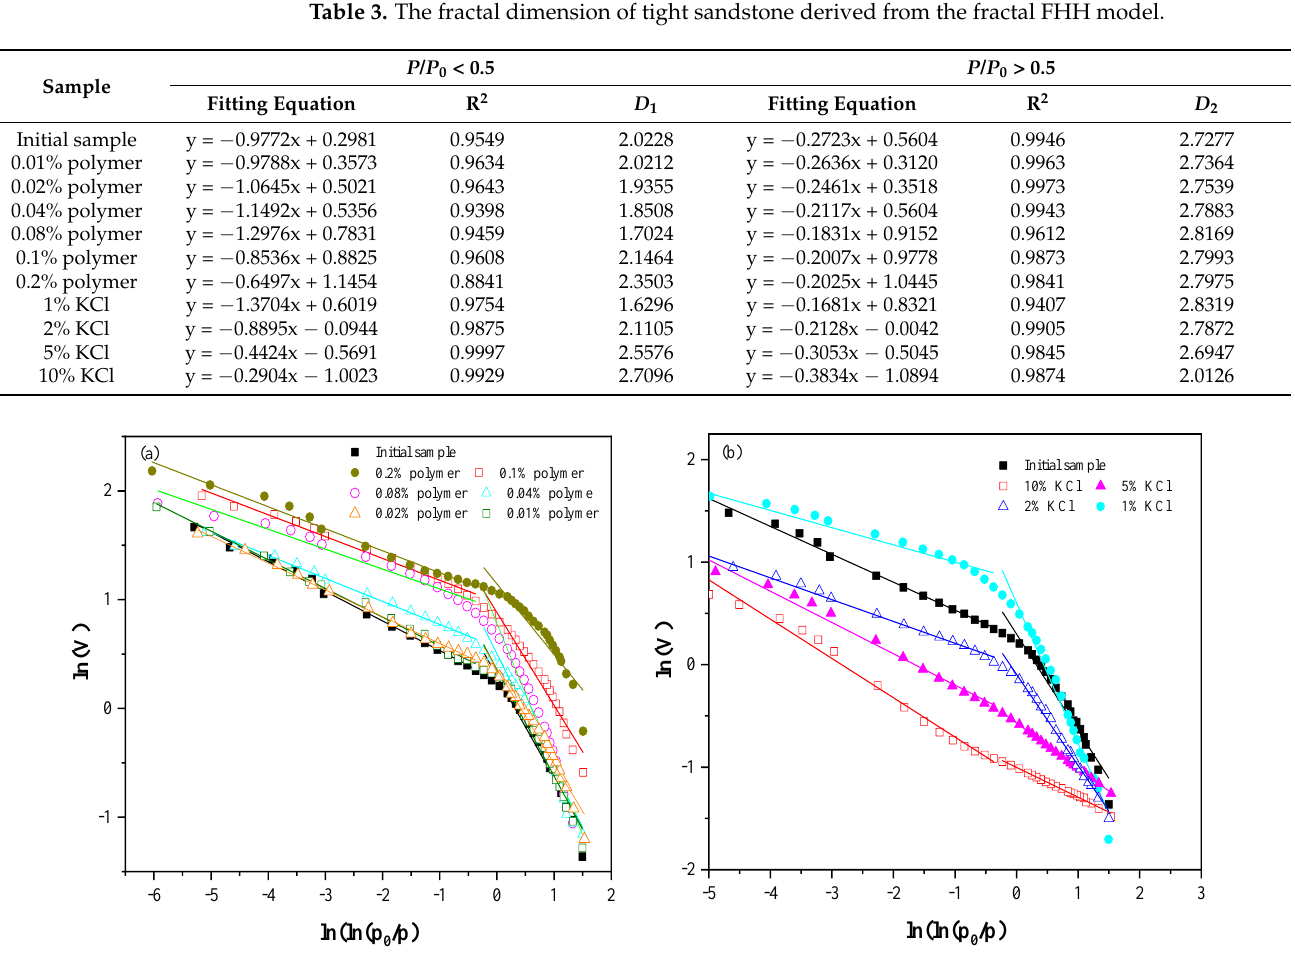
Figure 5. The fractal characteristics of samples based on nitrogen adsorption data: ( a ) polymer and ( b ) KCl.